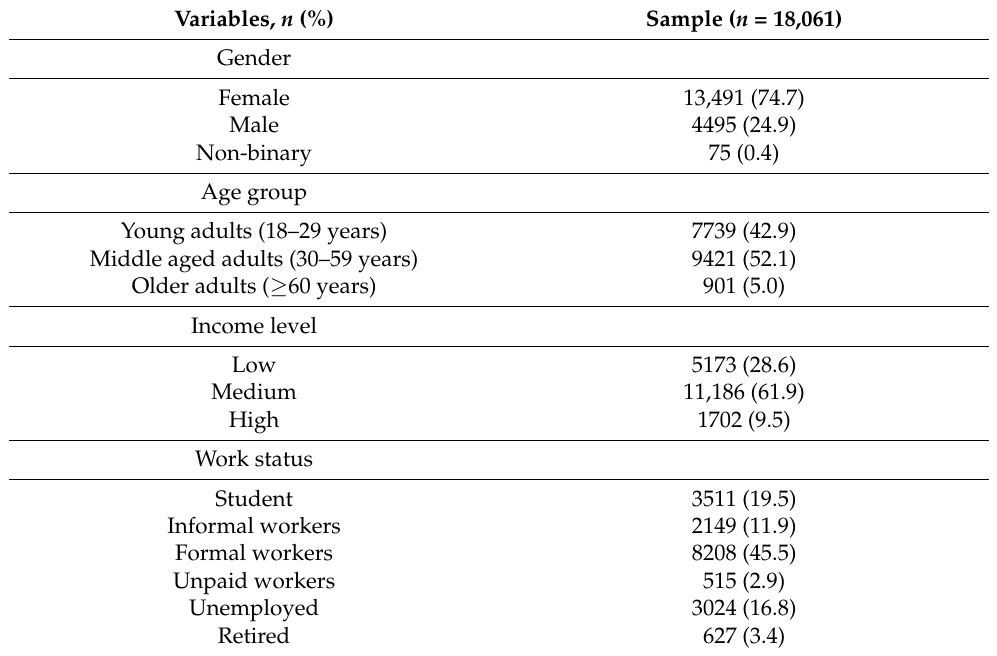
Table 1. Socio-demographic